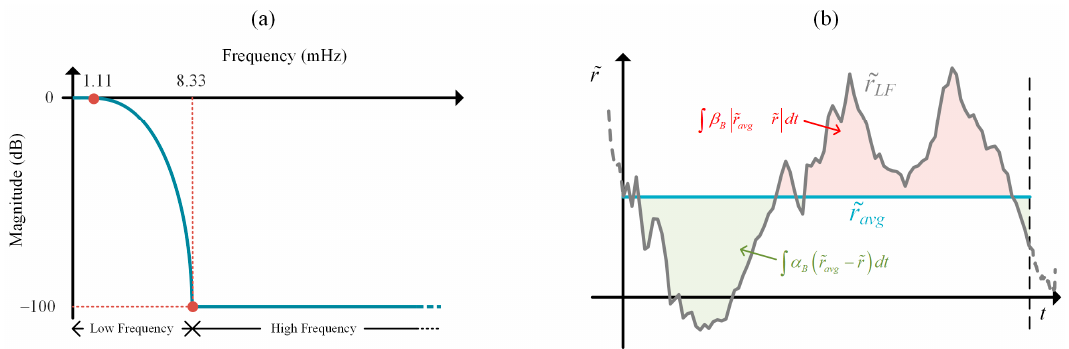
Figure 5. FBM main details: ( a ) transfer function of the LPF; ( b ) averaged power achieved by full peak-shaving ( r ̃ avg ).